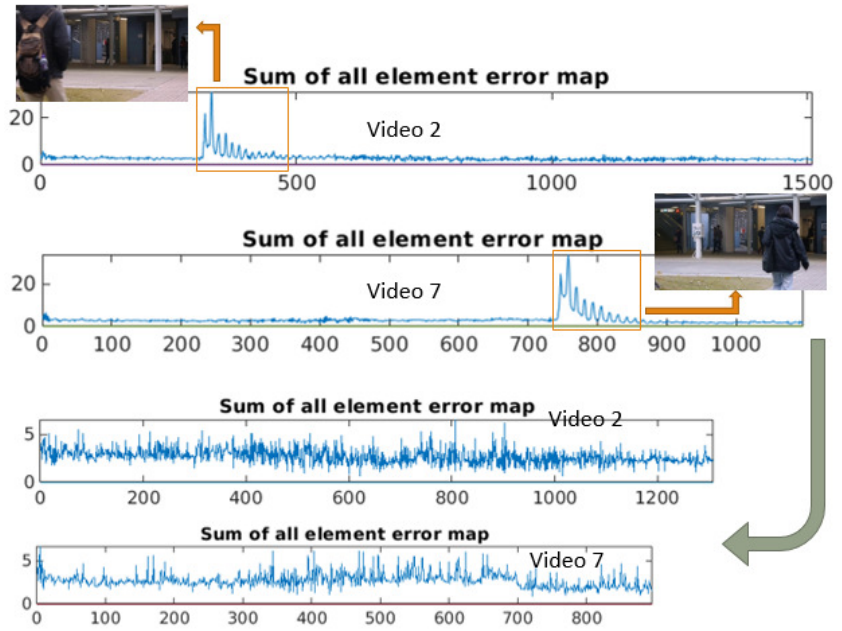
Figure 5. Example of outliers removing on Avenue dataset. Not to do it manually, we train CGAN-2 on training set to produce output images. Then we accumulate MSE values between output and ground-truth images for all 3 channels and we draw the corresponding values. We can easily observe some peaks occurring at the abnormal frames on training videos. We remove the outlier images corresponding to the peaks to obtain a new clean Avenue training set. Best viewed in